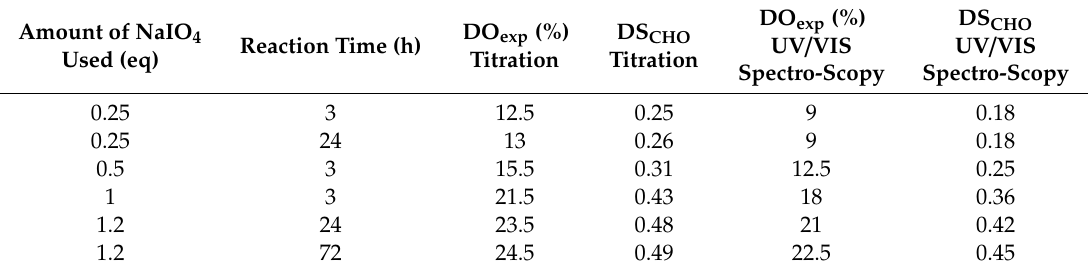
Table 1. Reaction conditions for oxidation of native alginate with the corresponding degrees of oxidation and substitution.